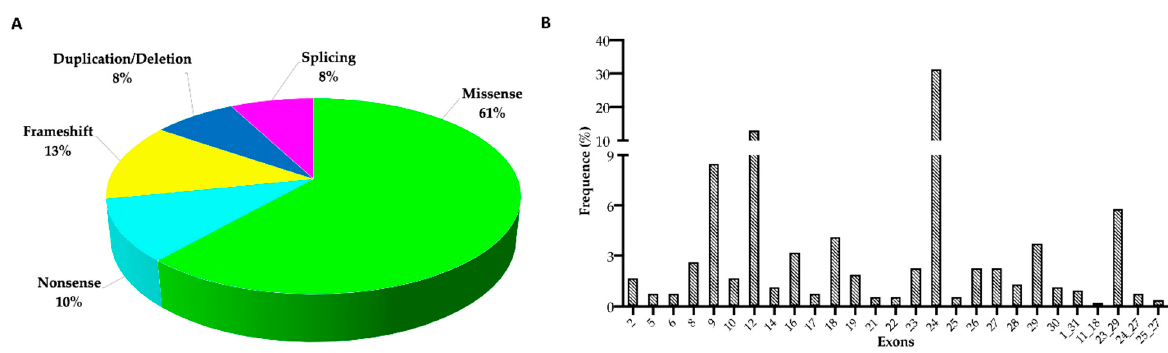
Figure 2. Type and frequency of ABCC6 rare sequence variants. ( A ) Distribution of the different types of rare sequence variants found in the ABCC6 gene. ( B ) Frequency distribution of ABCC6 rare sequence variants at exon-level in Italian PXE patients.